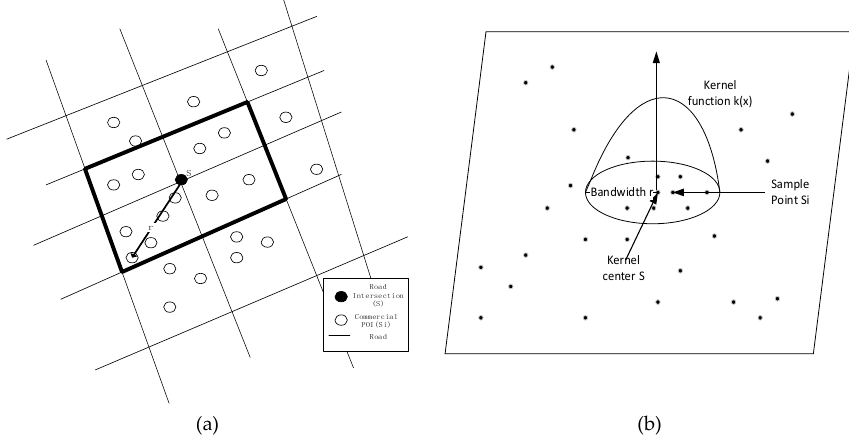
Figure 3. Illustration of commercial-intersection KDE: ( a ) the delimitation of road intersection neighborhood, and ( b ) simple example of commercial-intersection kernel function.